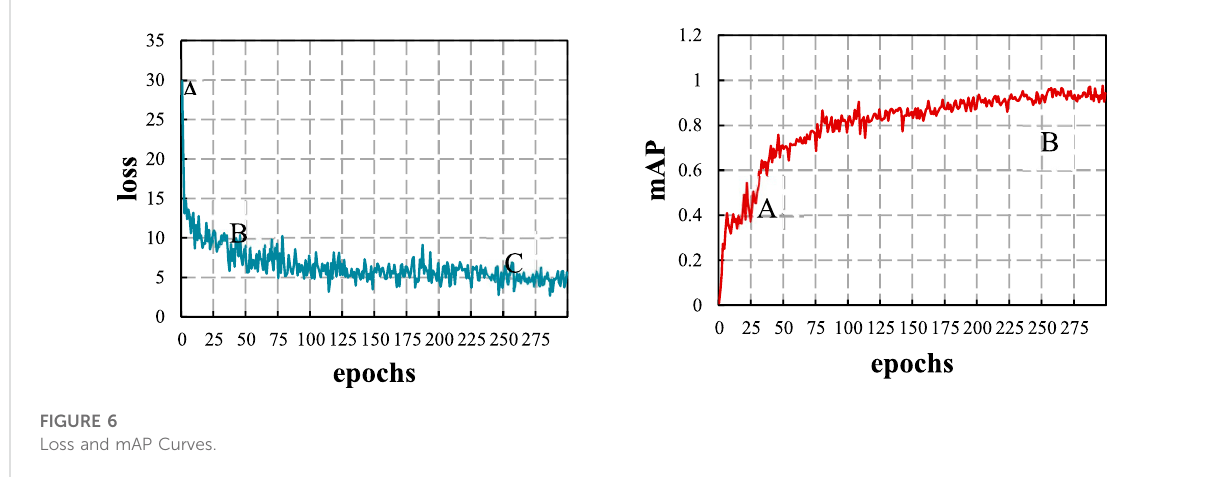
FIGURE 6 Loss and mAP Curves.